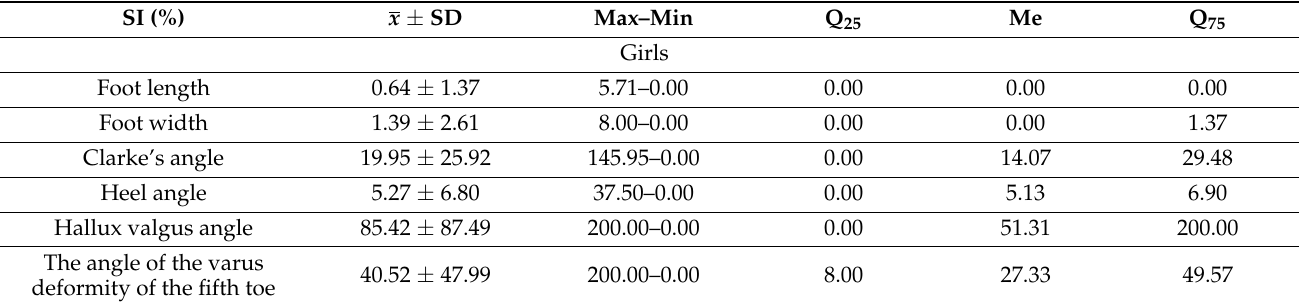
Table 4. Descriptive statistics of symmetry ratios for foot structure indices of the examined